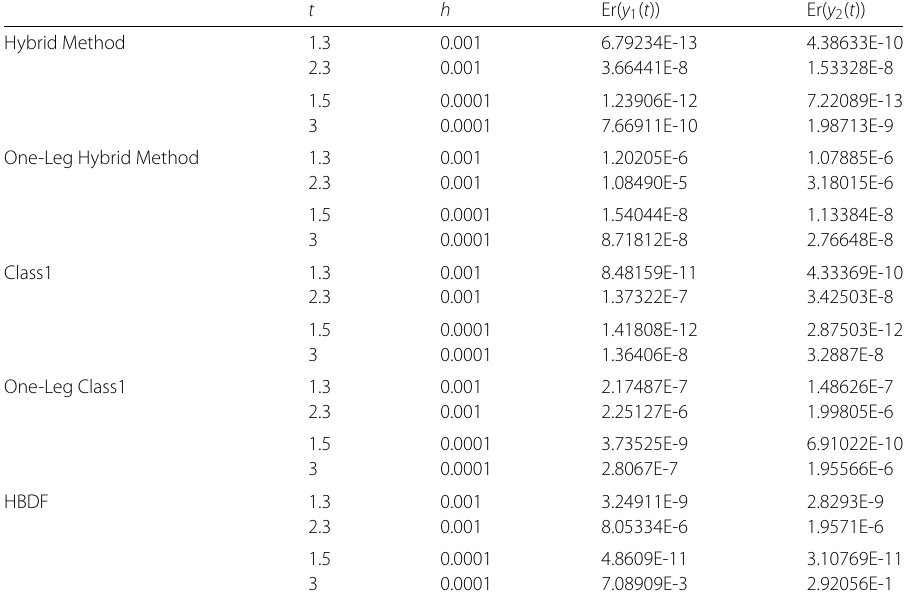
Table 7 The error of the second test